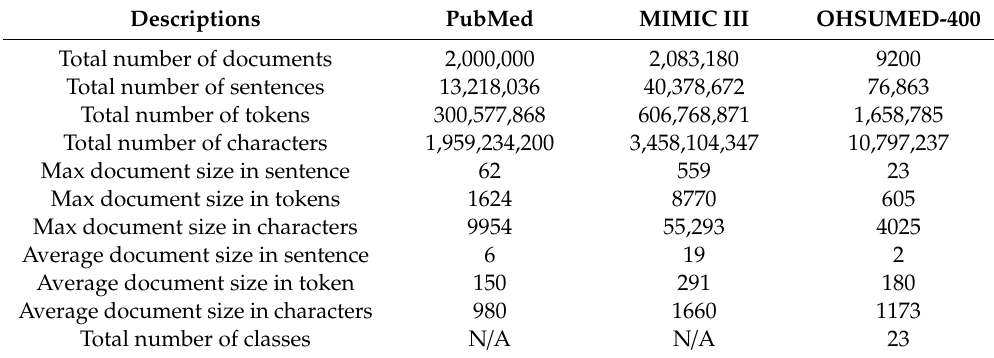
Table 1. Basic statistics about the three datasets used in this